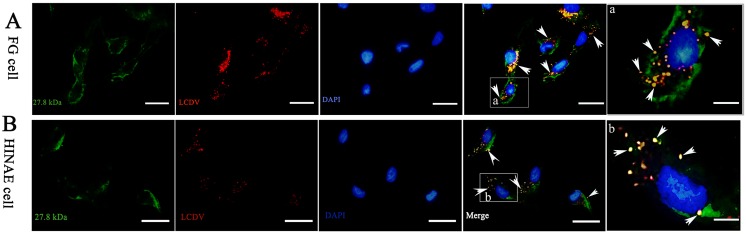
Co-localization of LCDV and 27.8R in FG and HINAE cell surface.FG cells (A) and HINAE cells (B) were exposed to LCDV at 22°C for 2 h and stained with mouse anti-27.8R MAbs and rabbit anti-LCDV serum for detection of 27.8R (green) and LCDV (red) simultaneously. The merged yellow signals (arrows) indicated the co-localization of LCDV and 27.8R protein on cell surface. Cell nuclei were counterstained in blue by DAPI. Scale bar = 20 μm. (a) and (b) were the higher magnification view of the co-localized area in FG and HINAE cells, respectively, scale bar = 5 μm.